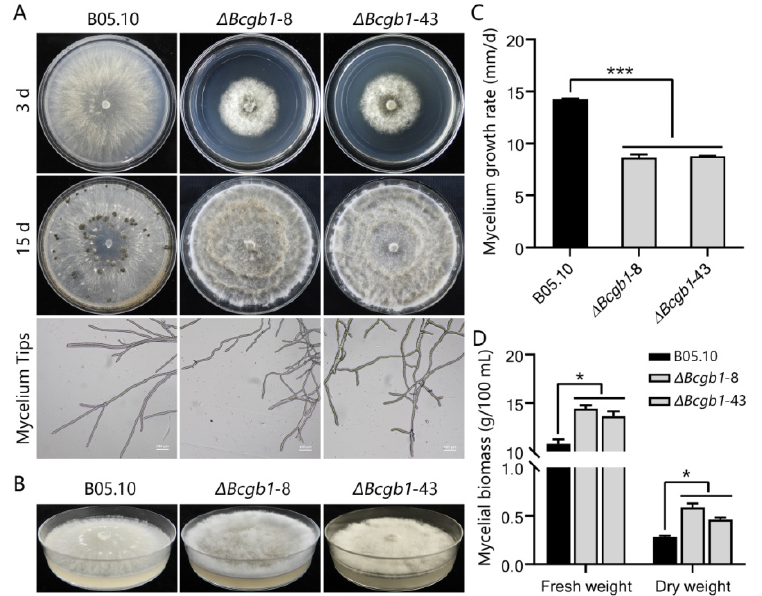
Figure 2. Bcgb1 is required for mycelial growth, conidiation, and sclerotia formation. ( A ) Colony morphology (3 d and 15 d) and mycelium tips (48 h) of the indicated strains cultured on PDA at 20 °C. ( B ) Aerial hyphae growth is increased in the ∆ Bcgb1 mutants after incubation on PDA for 7 days at 20 °C. ( C ) Mycelial growth rate of the indicated strains cultured on PDA at 20 °C *** p < 0.001. ( D ) Mycelial biomass of the indicated strains cultured in PDB at 20 °C for 2 d. * p < 0.05.